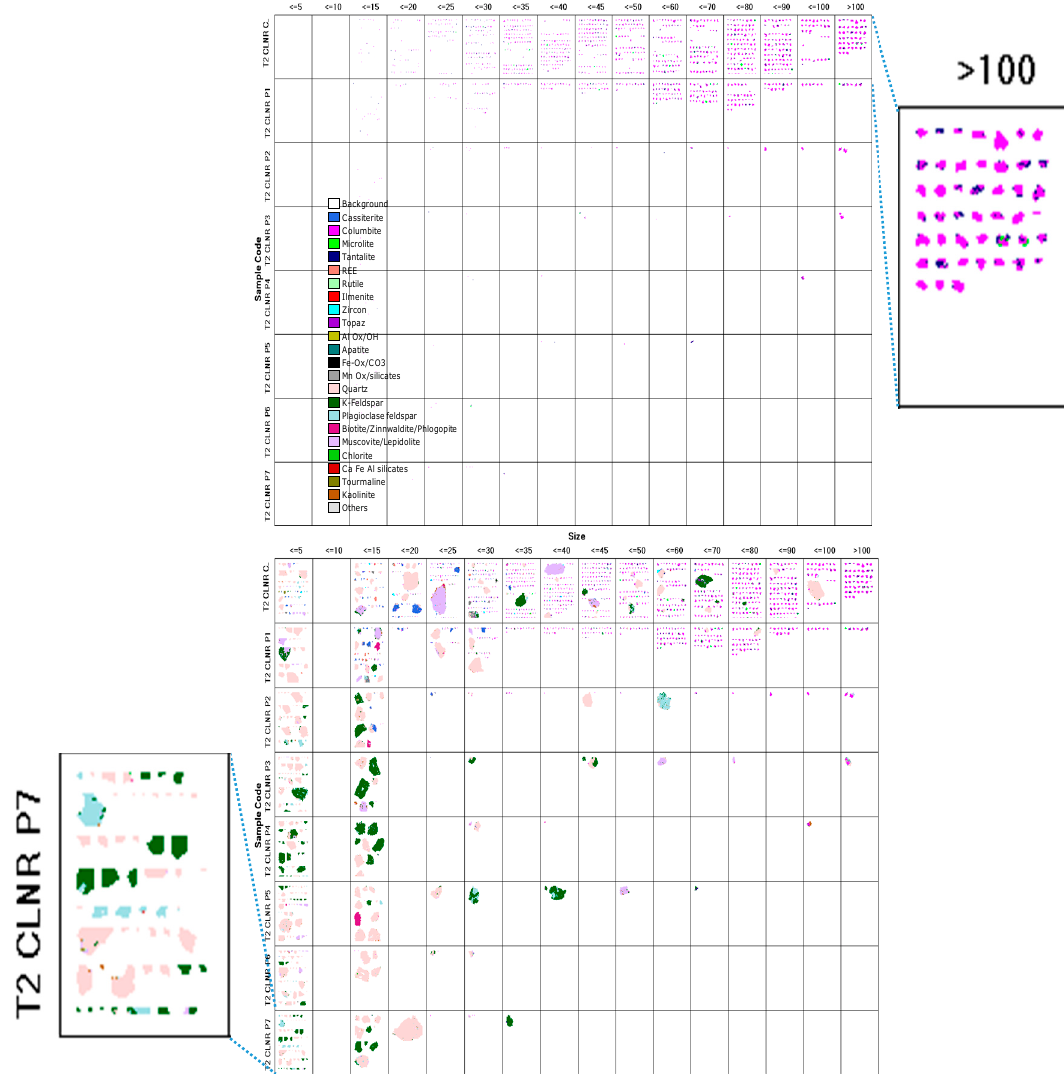
Figure 22. Ta–Nb vs Size, Ta–Nb combined and all other minerals invisible for ease of viewing ( top );